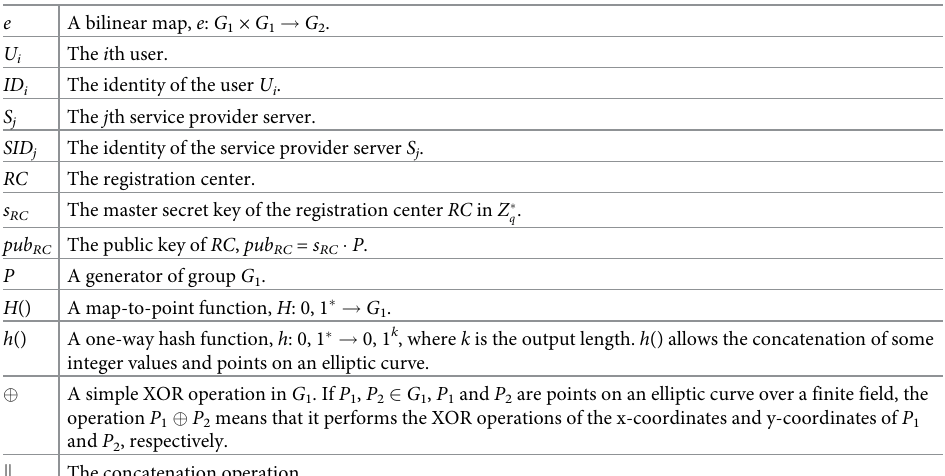
Table 1. Notations used in the proposed